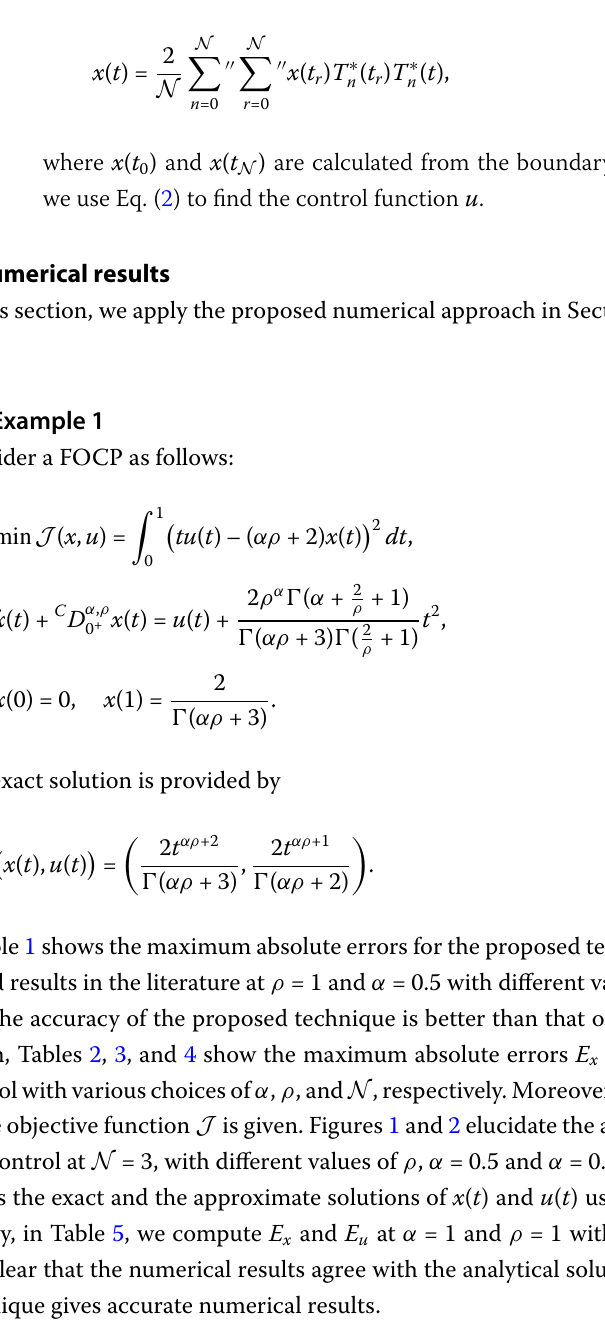
Table 1 Maximum absolute errors of x ( t ) at various values of N N Sweilam et al. [34] Bhrawy et al. [8] Our results